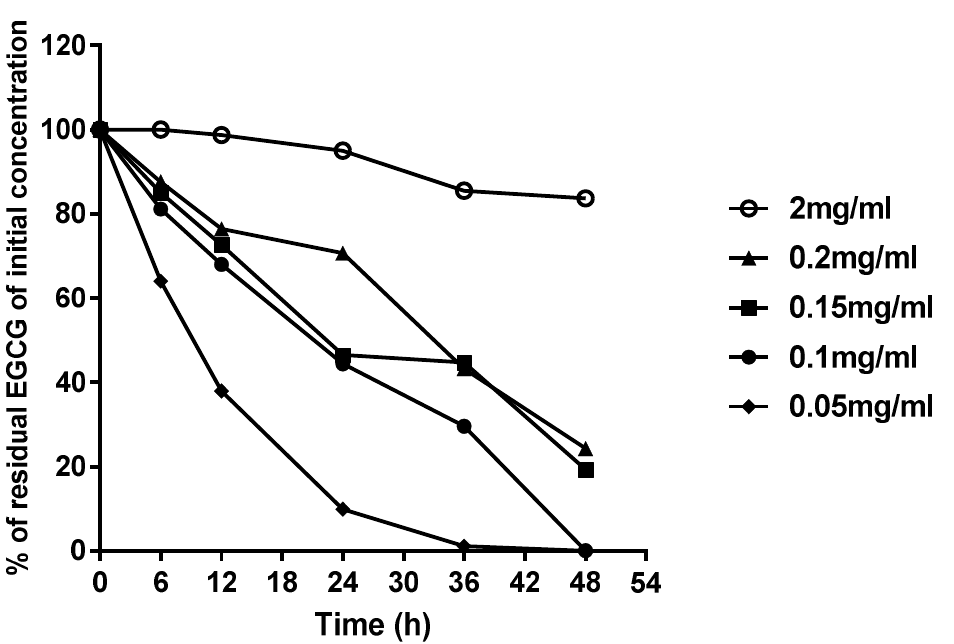
Figure 3. Stability of all concentrations of EGCG aqueous solutions under condition (D): exposed to sunlight and air.